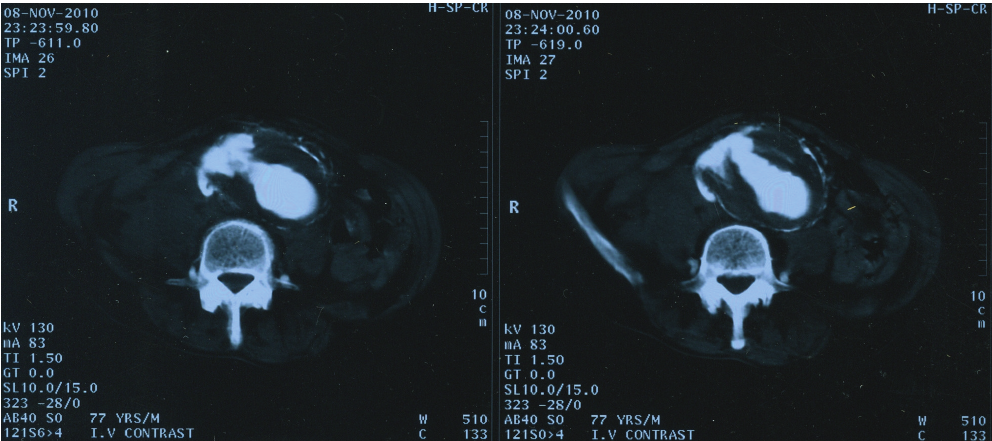
Figure 1: Abdominal CT identifying a large 7.8cm AAA with evidence of retroperitoneal rupture. Notice the synchronous contrast filling of the aorta and IVC and their communication through the sac, indicating aortocaval fistulation.